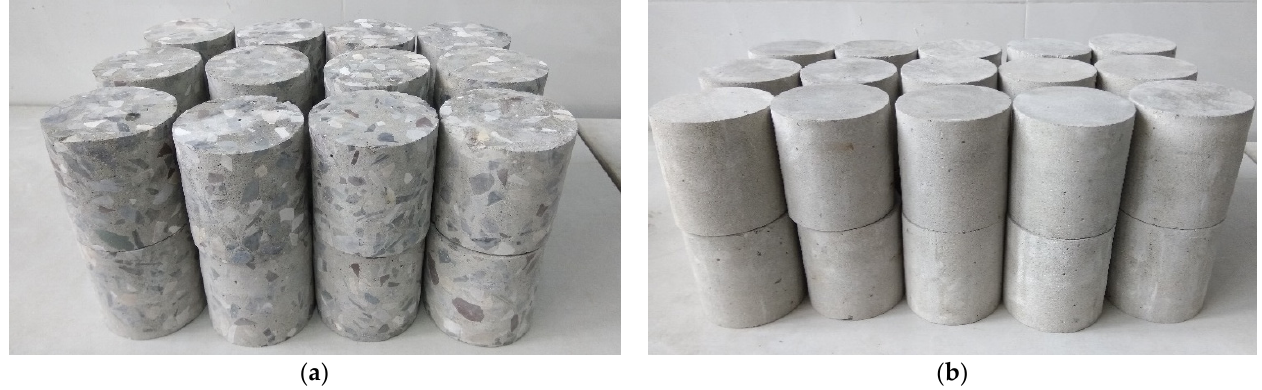
Figure 2. Specimens for SHPB test: ( a ) Mortar, ( b )